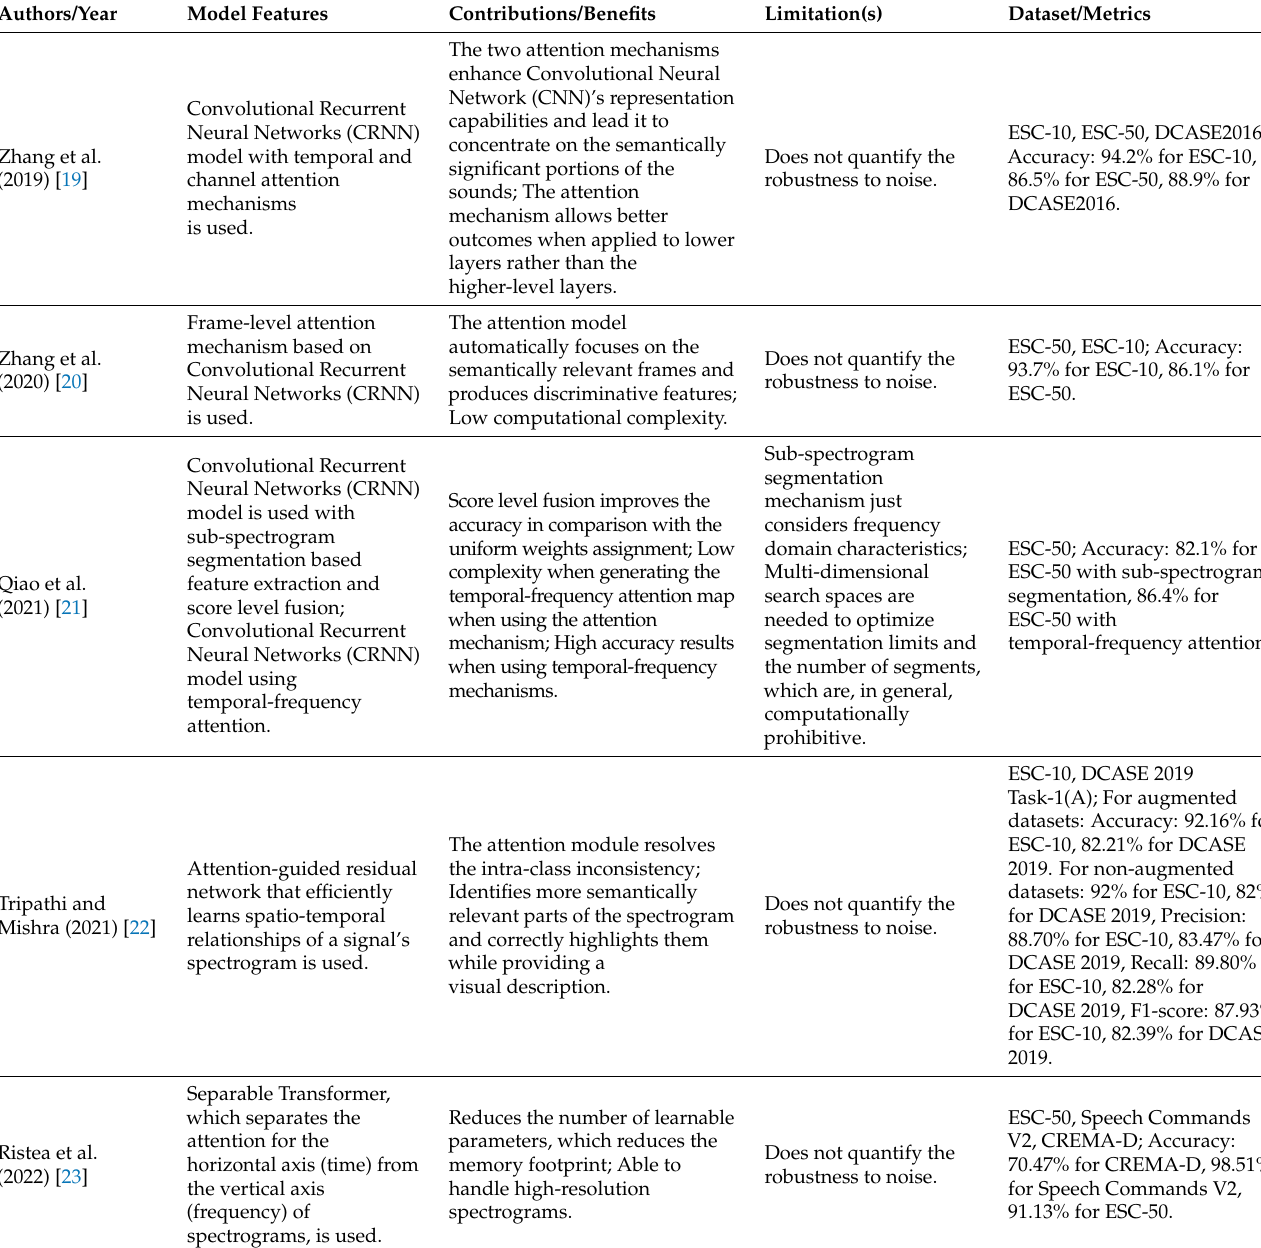
Table 4. Resume of the research articles found on audio segmentation with attention